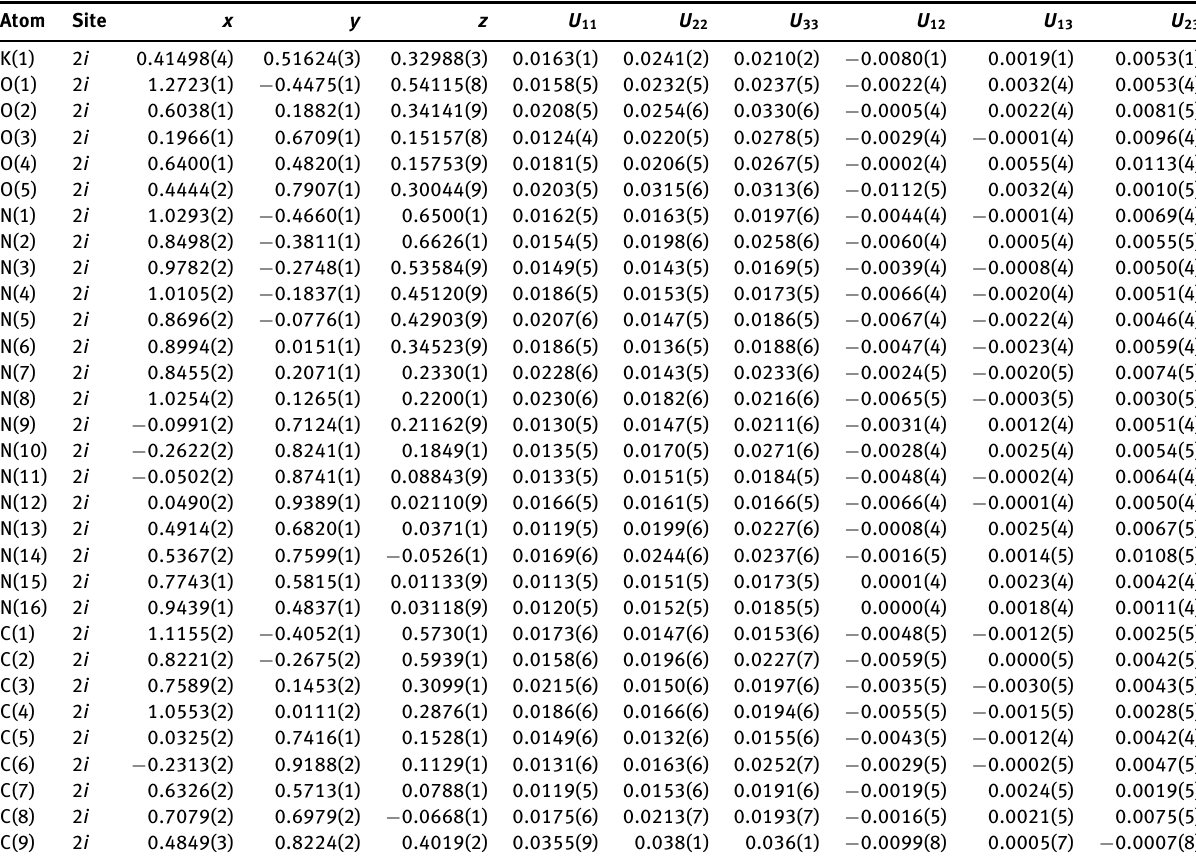
Table 3: Fractional coordinates and atomic displacement parameters (Å 2